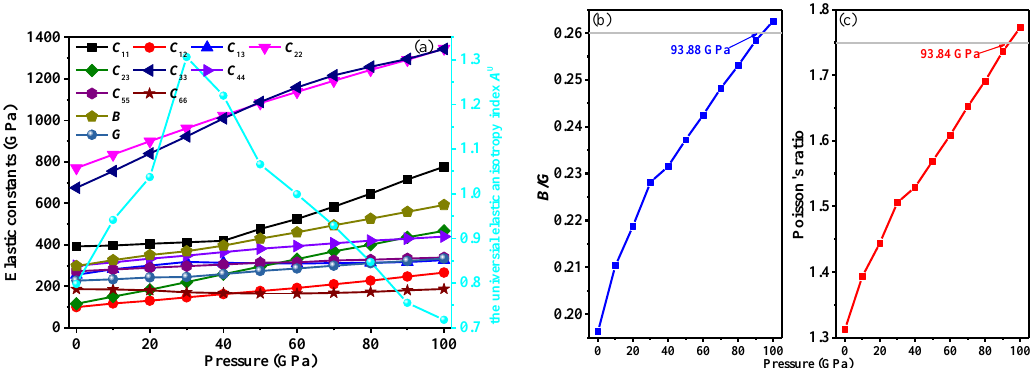
Figure 4. Elastic constants and elastic modulus ( a ) and B / G ratio ( b ); Poissons’ ratio v ( c ) of Pnma -BN as a function of pressure.